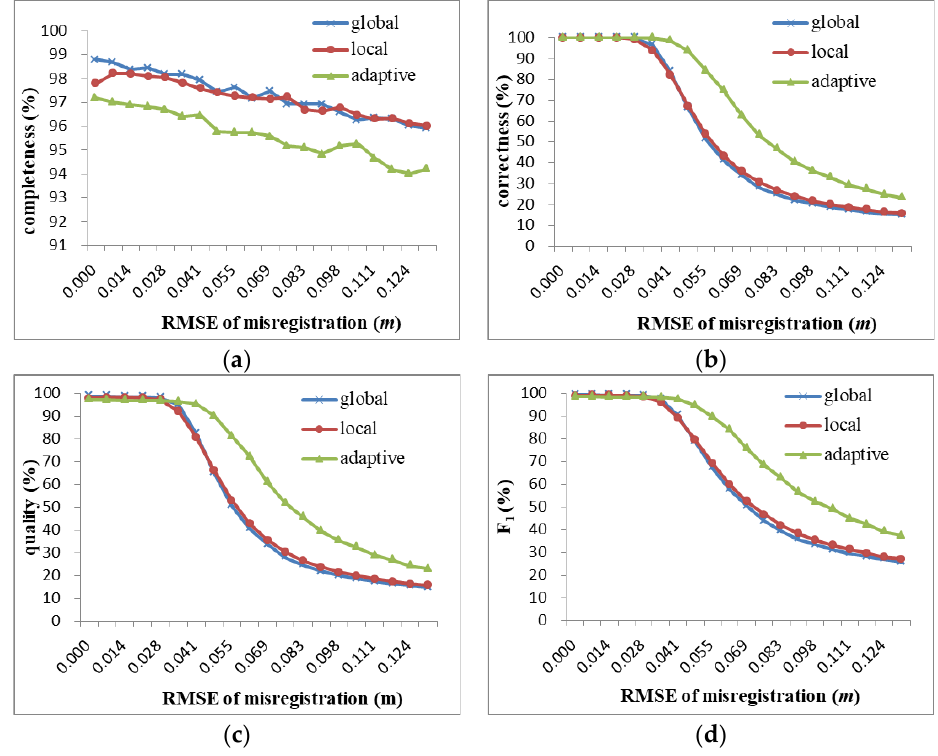
Figure 6. Results of experiments 2: ( a – d ) the results of the indicators completeness, correctness, quality, and F 1 , respectively, through these methods.